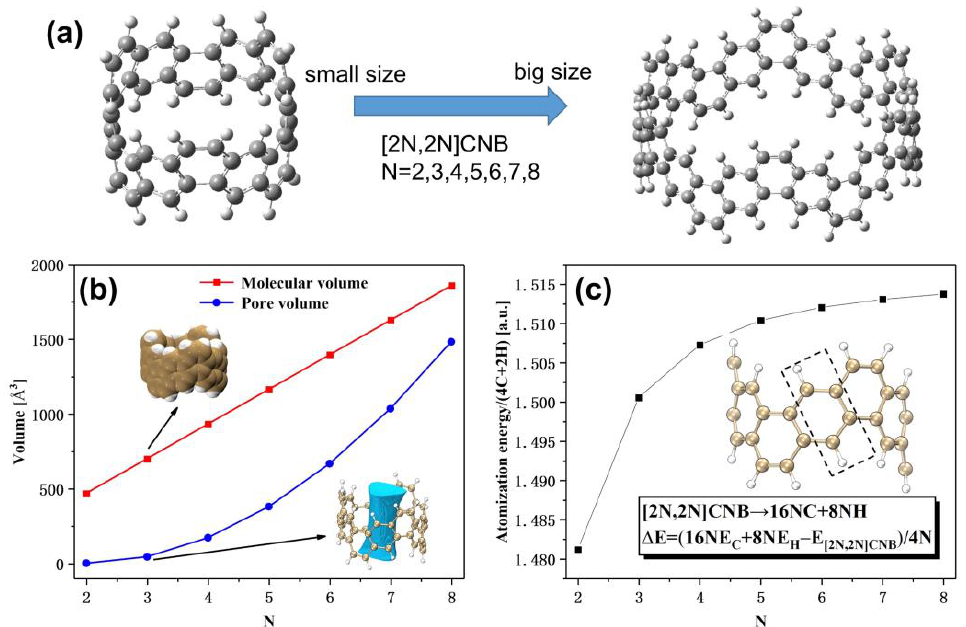
Figure 1. ( a ) Schematic diagram of the geometric structure of [2N,2N]CNB, with gray (white) spheres representing carbon (hydrogen) atoms. ( b ) Molecular volume and pore volume of [2N,2N]CNB. ( c ) The atomization energy per (4C + 2H) of [2N,2N]CNB. E C and E H are the electron energies of carbon and hydrogen atoms, respectively.